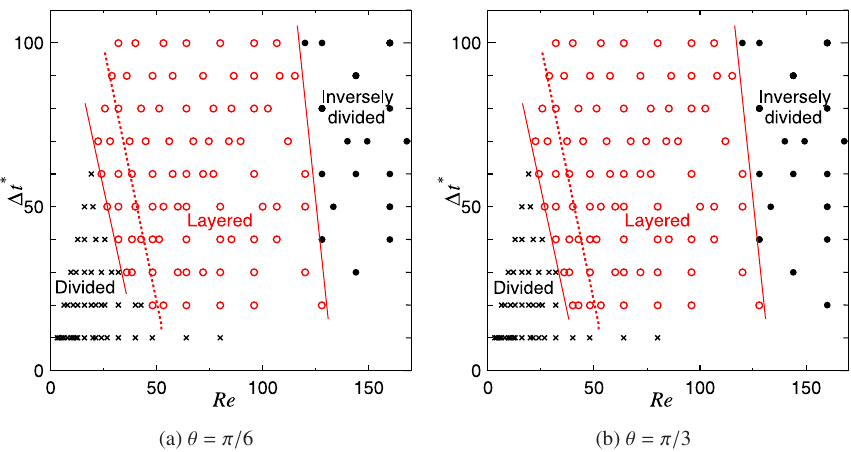
Fig. 11 Comparison of the flow pattern maps with the diverging angle θ of the mixing channel. The dotted lines indicate the condition for ideal layered